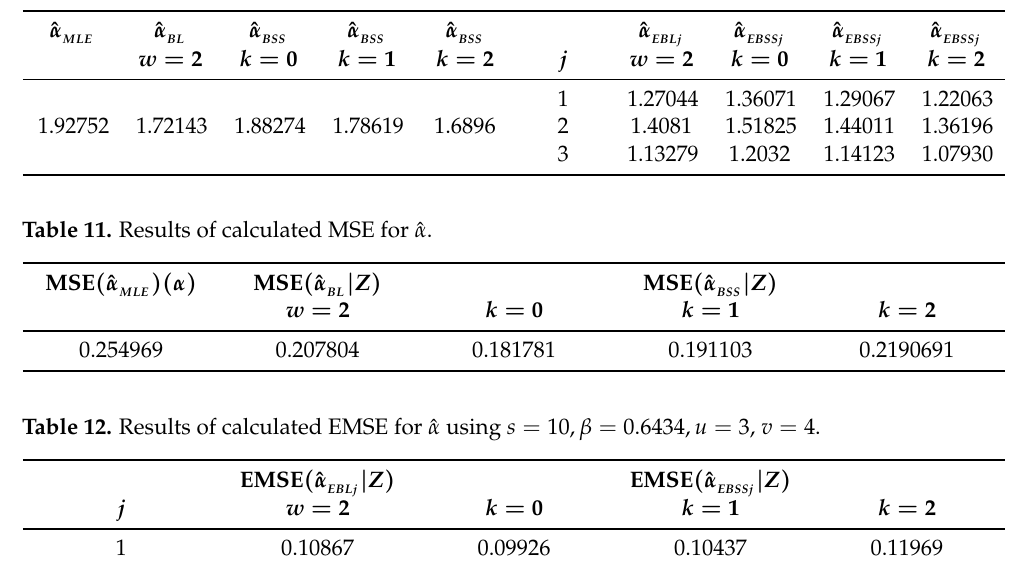
Table 10. Estimations of α , with s = 10, β = 0.6434, u = 3 and v = 4.